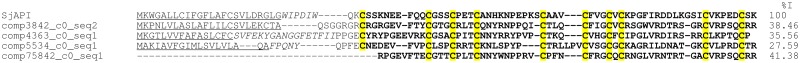
Comparison of Ascaris-type protease inhibitor peptides found in U. yaschenkoi transcriptome.Multiple alignment of U. yaschenkoi sequences that code for ascaris-type protease inhibitor compared against the ascaris-type protease inhibitor precursor from Scorpiops jendeki scorpion (SjAPI; GenBank: P0DM55). The sequence of comp75842_c0_seq1 is partial. The predicted signal peptide is underlined; putative propeptides is in italics and the common trypsin inhibitor like cysteine rich domain in bold with its ten cysteines highlighted in yellow. The percentage of identity (%I) with respect to SjAPI is shown. Note. Sequence comp4363_c0_seq1 encodes the same precursor as sequence comp4053_c0_seq1 (not shown); comp5534_c0_seq1 encodes the same precursor as comp4356_c0_seq1 (not shown) and comp135491_c0_seq1 (not shown) codes for the same partial sequence as comp75842_c0_seq1.